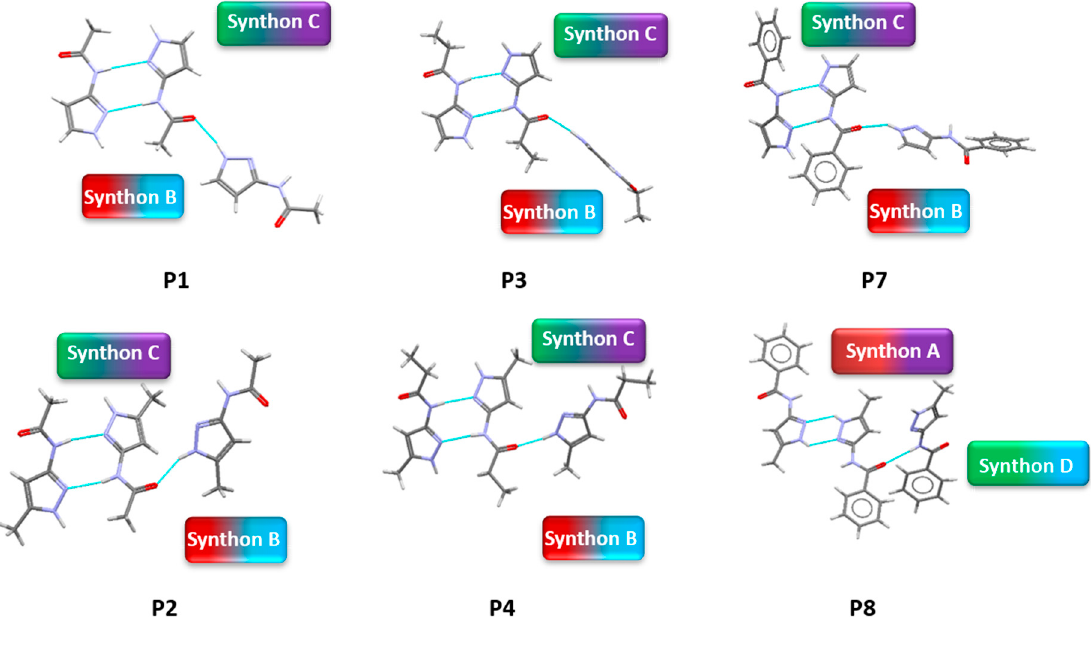
9 Figure 3. Predicted hydrogen-bond coordination P1 – P12 (D: hydrogen-bond donor, A: hydrogen-bond acceptor; green: optimal interactions, red: sub-optimal interactions). 3.5. Experimentally Observed Crystal Structures Suitable crystals of P1, P2, P3, P4, P7, P8, P10 and P11 were obtained by slow solvent evaporation method using methanol solvent. Few other solvents such as ethanol, THF,